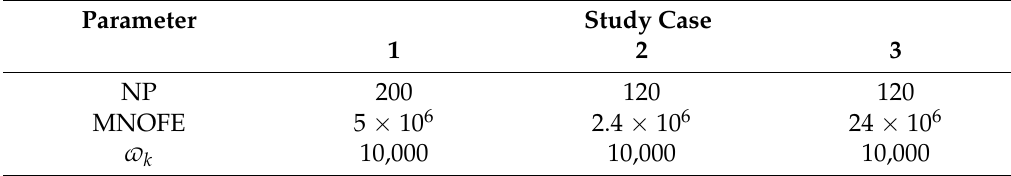
Table 6. The Maximum Number of Objective Function Evaluation (MNFE), the Population Number (NP), and the penalty factor chosen for each study